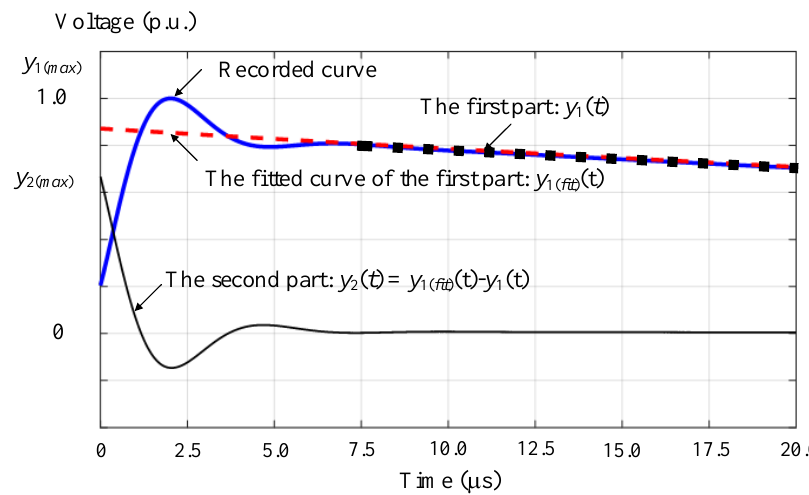
Figure 2. Voltage curves for determination of full lightning impulse voltage parameters using the LL method.